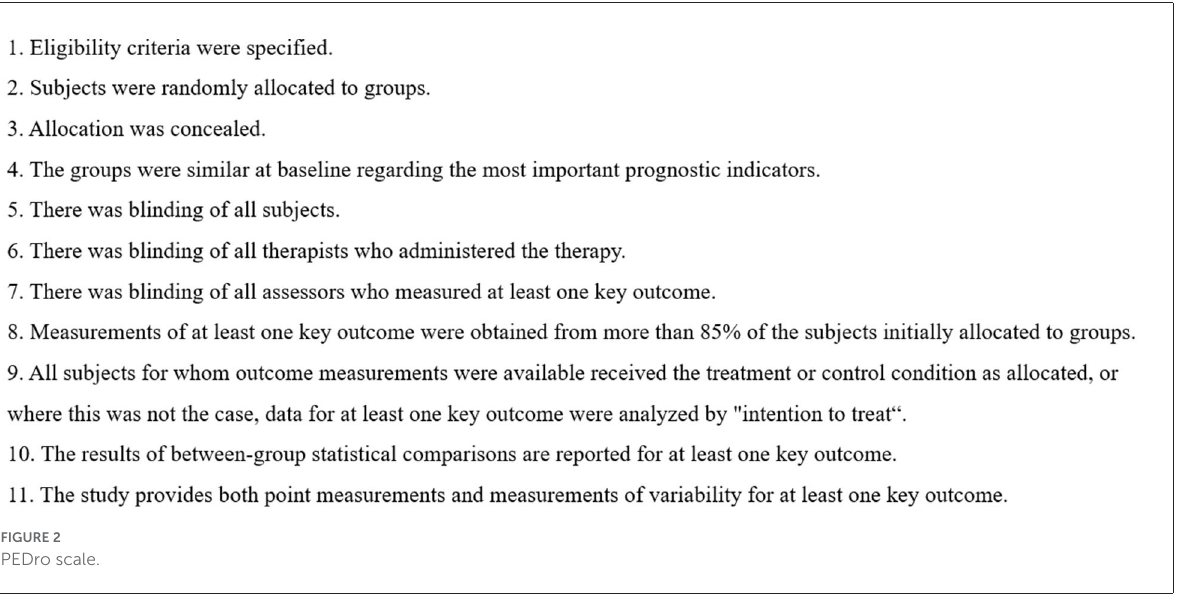
FIGURE2 PEDro scale.